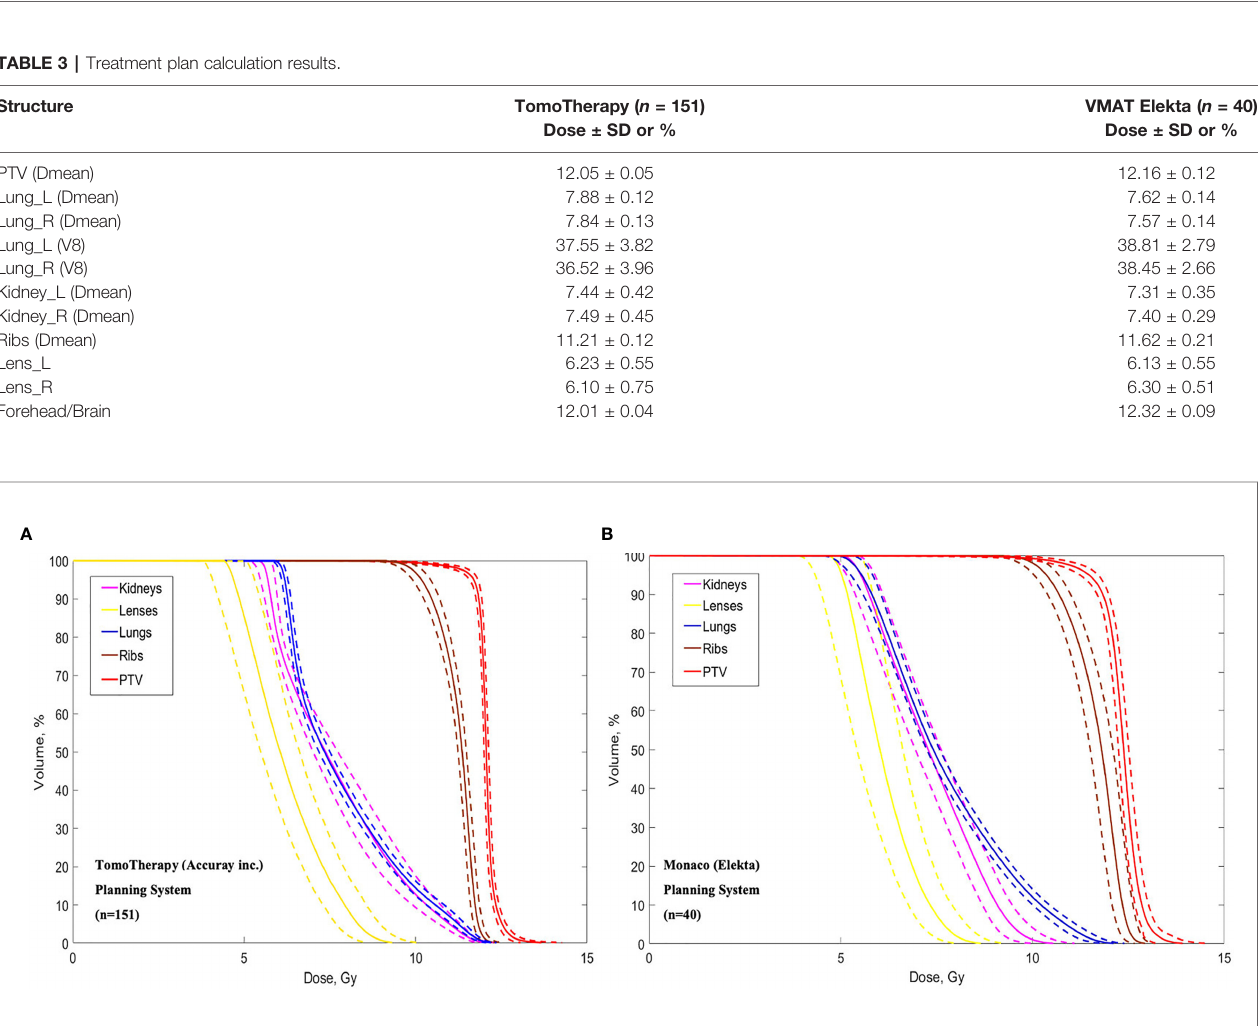
FIGURE 3 | Dose volume histograms calculated in the TomoTherapy (A) and Monaco (B) Planning systems. Dotted lines show standard